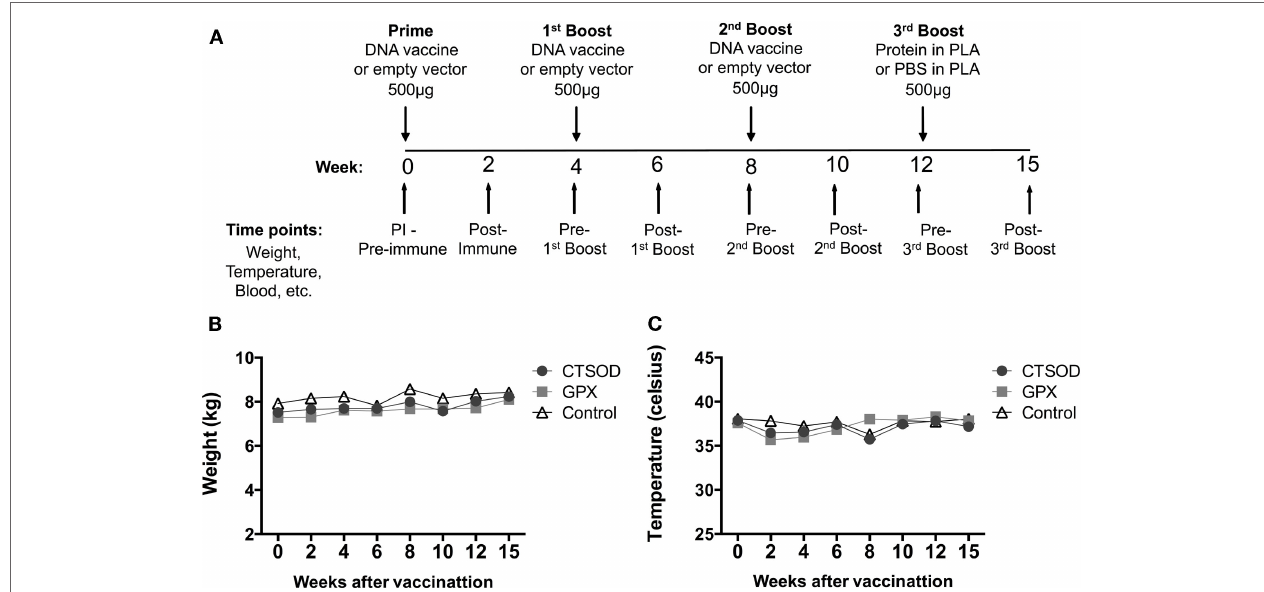
demeanor observations (data not shown) and bi-weekly for weight and temperature. In (B,c) , the average results of the bi-weekly monitoring of weight (B) and temperature (c) from baboons before and after immunizations with antioxidant vaccines during safety and toxicity evaluation. Animals